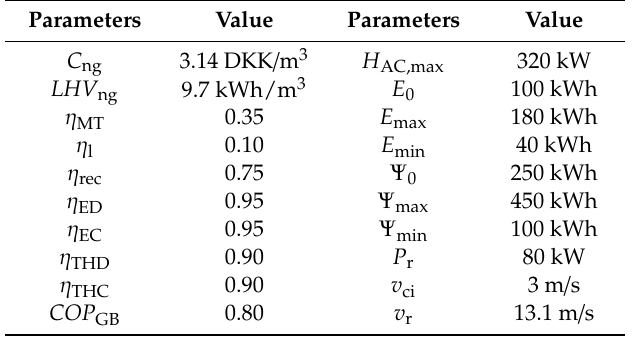
Table 2. Relevant parameters for components in CCHP